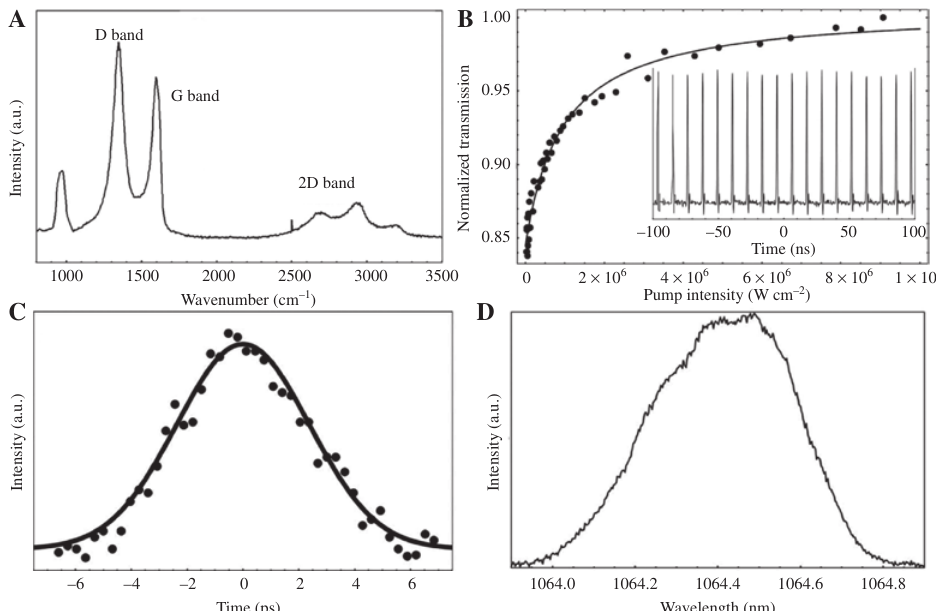
Figure 9: Performance of the first graphene mode-locked solid-state laser. (A) Raman spectrum of graphene. (B) Transmission of graphene vs. pump intensity. Inset: CW mode-locked pulse train. (C) Autocorrelation trace and (D) corresponding output spectrum of the graphene mode-locked laser. Reproduced with permission [164]. Copyright 2010, AIP Publishing.